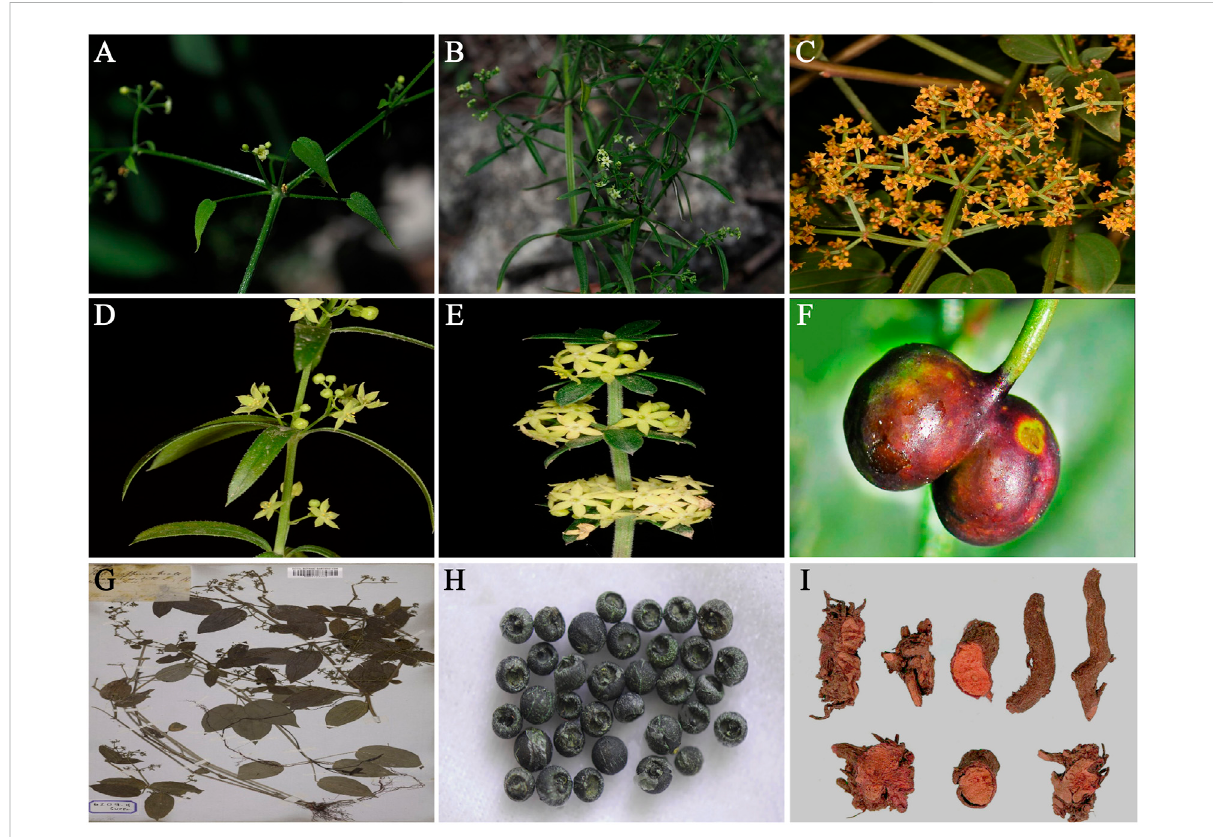
FIGURE 3 Botanical diagramof R. cordifolia (Theimages (A,B,C,D,G) are obtained from KewBotanicalGarden (http://powo.science.kew.org/):and (F,H,I) the iPlant ( ppbc.iplant.cn ). The whole plant of R. cordifolia (A,B,C) ; the fl owers of R. cordifo lia (D,E) the fruits of R. cordifolia (F) ; The specimen of R. cordifolia (G) ; dry fruit of R. cordifolia (H) ; the dried root of R. cordifolia (I)